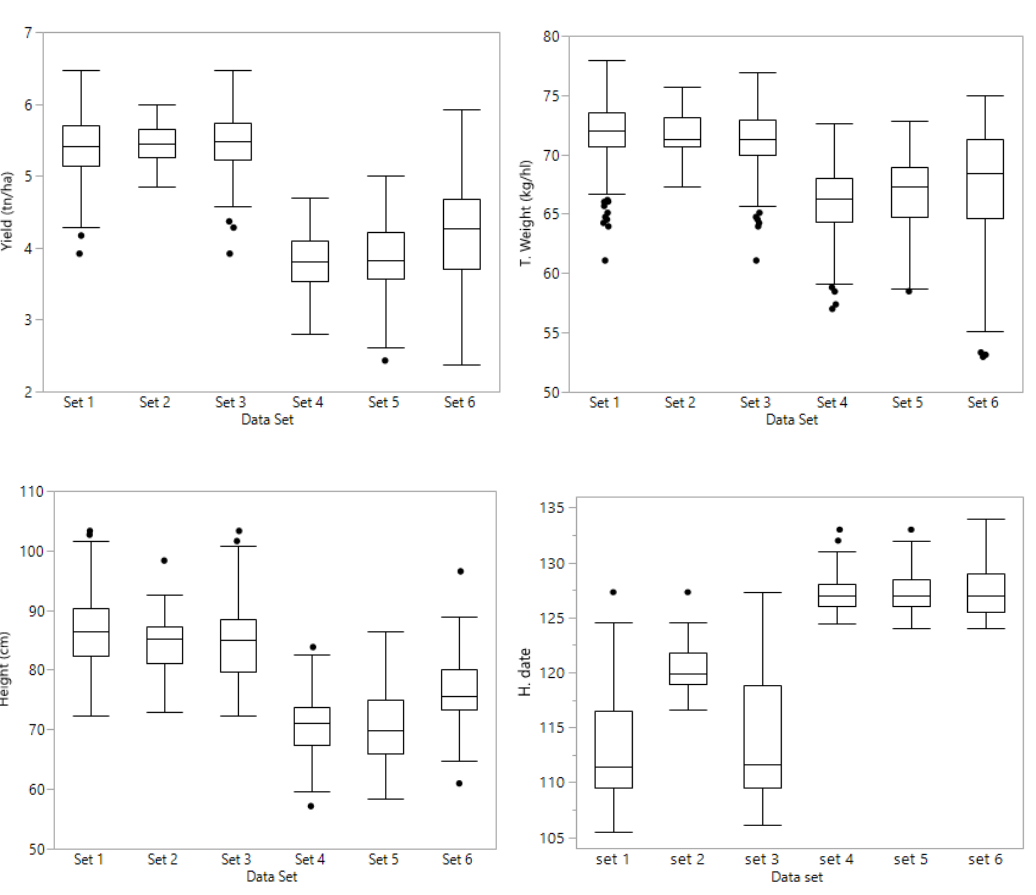
Figure 2. Boxplots for mean grain yield (t ha −1 ), test weight (kg hL −1 ), heading date (days after 1 January) and height (cm) for the six wheat data sets.